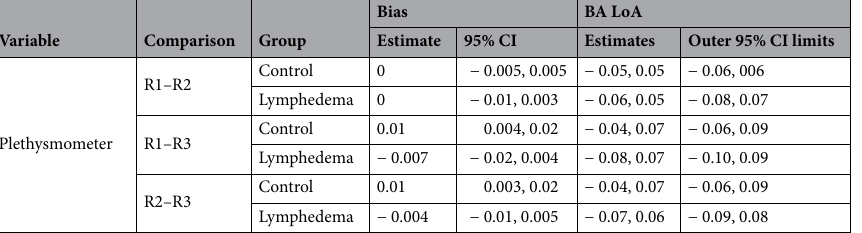
Electronic caliper. The estimated mean difference for the lymphedema hindlimb between the raters (R1, R2, R3) was 0.39 mm 95% CI [0.27, 0.51], 0.21 mm 95% CI [0.06, 0.36] and − 0.18 mm 95% CI [− 0.37, 0] for R1-R2, R1-R3 and R2-R3, respectively. For the control hindlimb the difference was 0.45 mm 95% CI [0.33, 0.57], 0.37 mm 95% CI [0.25, 0.50] and − 0.07 mm 95% CI [− 0.21, 0.07], respectively. The interrater agreement results for the electronic caliper are summarized in Table 3 and graphed in Fig. 6. Correlation analysis. µCT‑scans vs. plethysmometer. The correlation coefficient between the µCT-scans and the plethysmometer for the lymphedema hindlimb was 0.56, 95% CI [0.42–0.70] (p < 0.0001) across all raters.